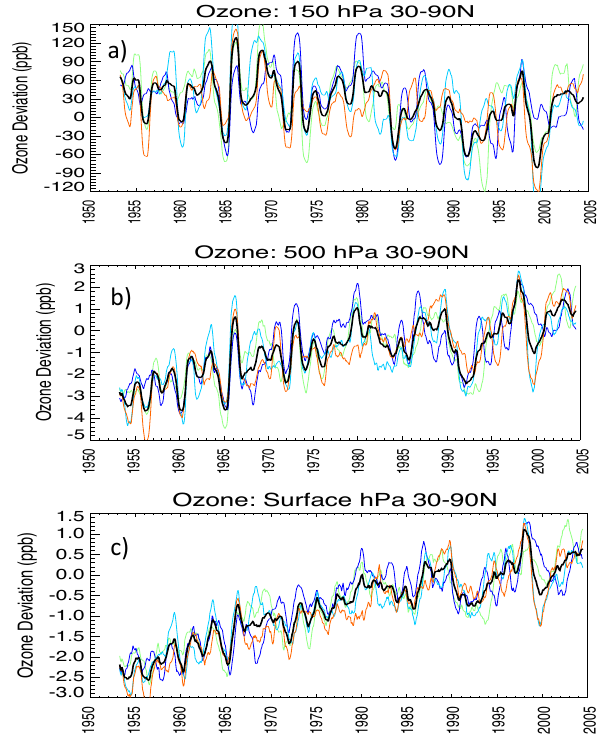
Figure 2. Ozone deviations (ppb) averaged from 30 to 90 ◦ N for each WACCM ensemble member (colored) and the deviation aver- aged over all ensemble members (black) at (a) 150hPa, (b) 500hPa and (c) the surface. Monthly ozone deviations are smoothed over 12 months. Deviations are from ozone averaged 1 January 1990–31 December